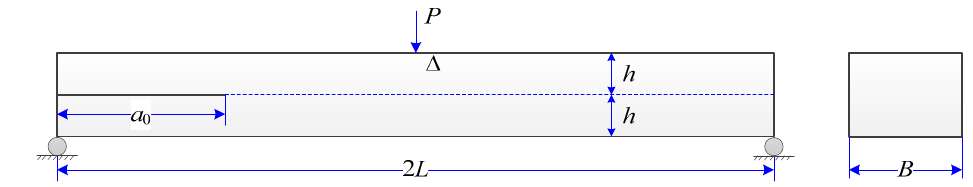
Figure 16. Configuration, loading, and boundary condition of an end notched flexural (ENF) model.